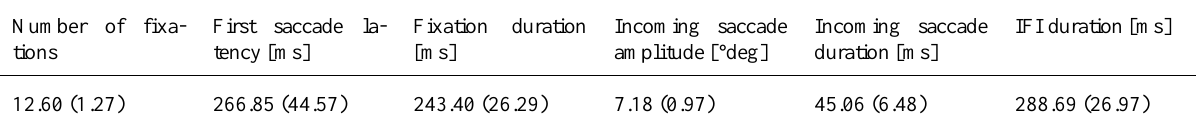
Table 1 Statistical summary: number of fixations, first saccade latency, fixation, saccade and Inter-Fixation Interval durations and saccade amplitude, based on individual means (std), during free exploration